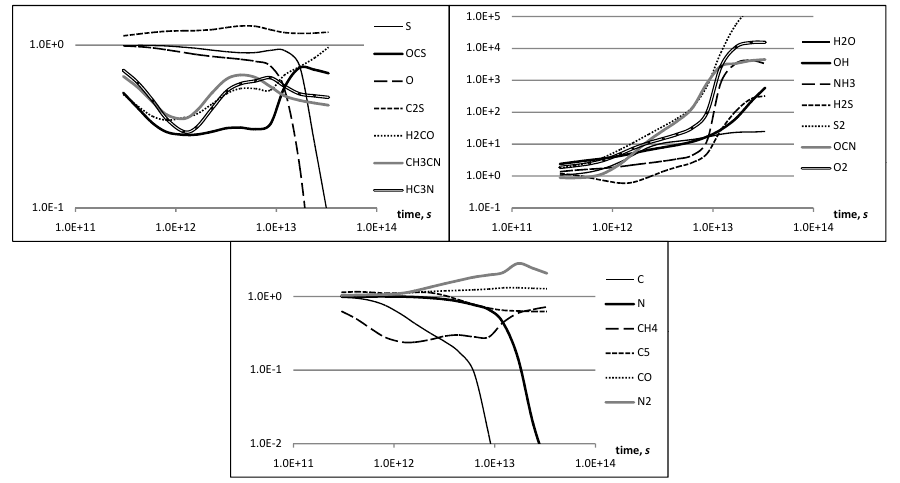
Fig. 6. The comparison of calculated total (gas + solid phase) abundances for selected species between Model 2 (with freeze processes) and Model 1. The ratio of Model 2 to Model 1 total abundances is shown. Pay attention to the M2/M1 (ordinate) scale for each